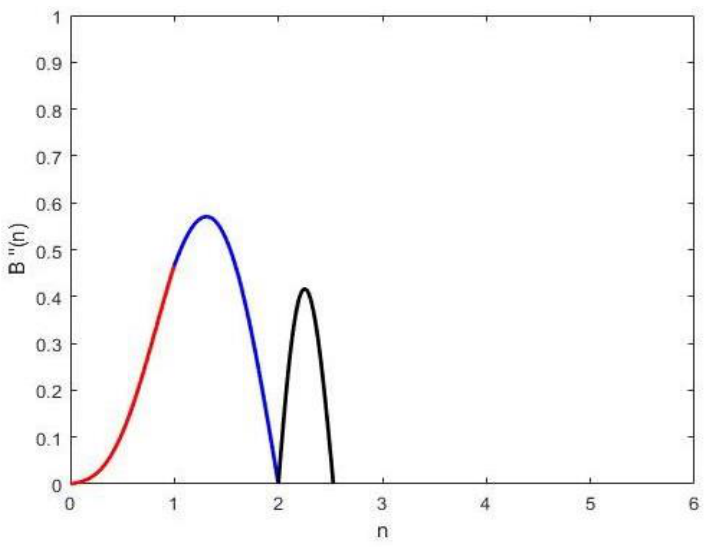
Figure 5. Plot of the second derivative of the basis